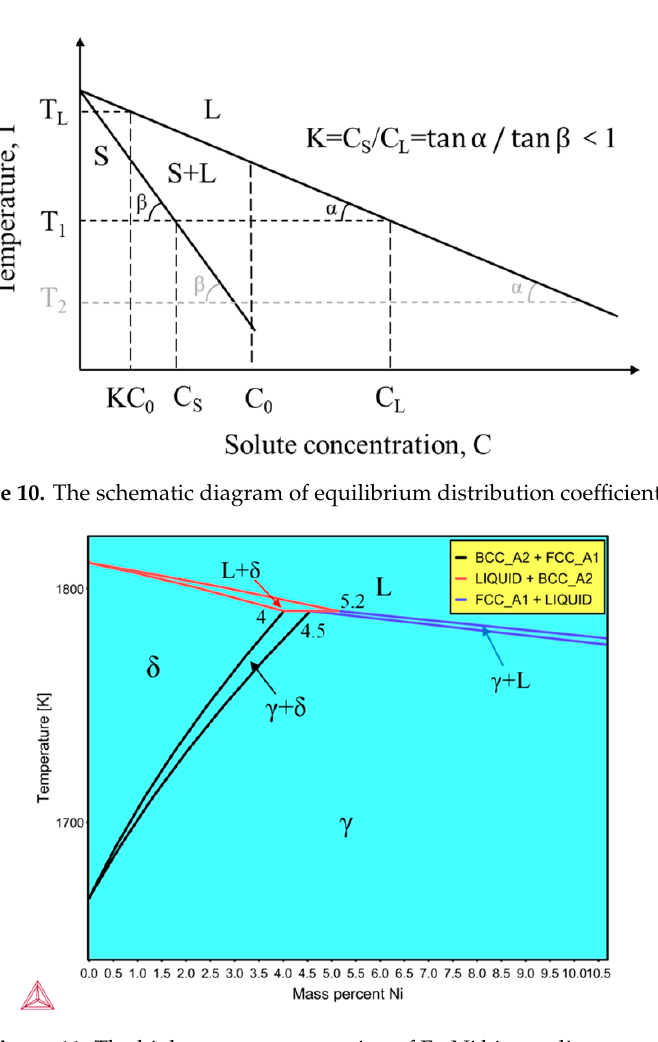
Figure 11. The high temperature portion of Fe-Ni binary diagram .